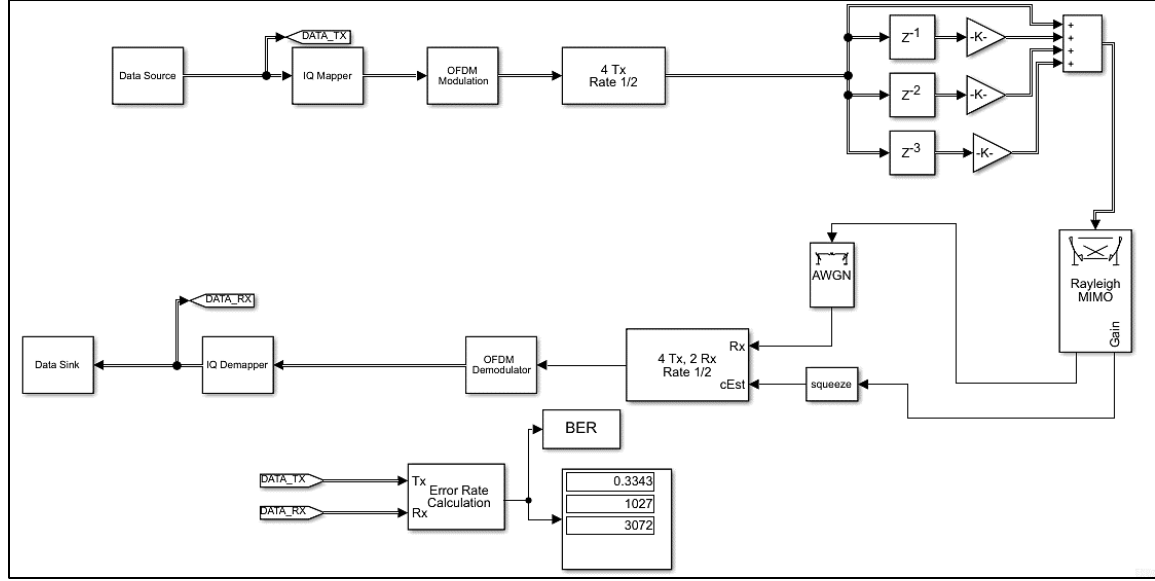
Figure 6. CDMA-MIMO-OFDM Model in Rayleigh